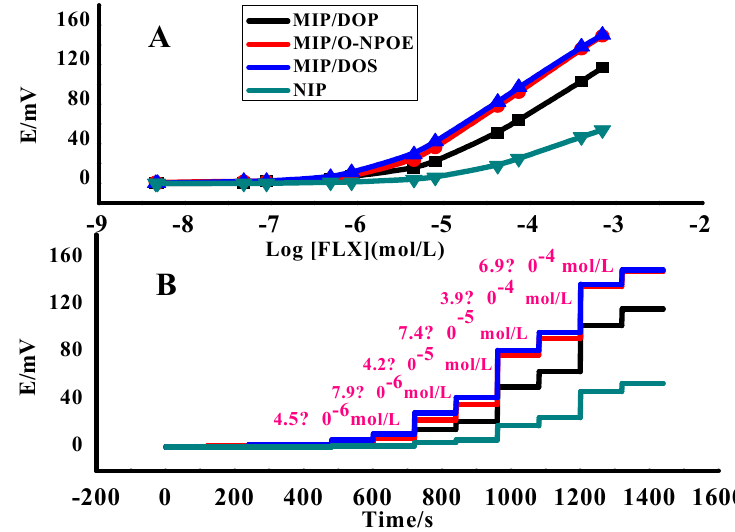
Figure 5. (A ) Calibration plots and ( B ) time response of non-imprinted polymer (NIP) and the proposed sensors in acetate buffer (0.01 M) pH = 4.5 with multi-walled carbon nanotube (MWCNT) as a transducer.